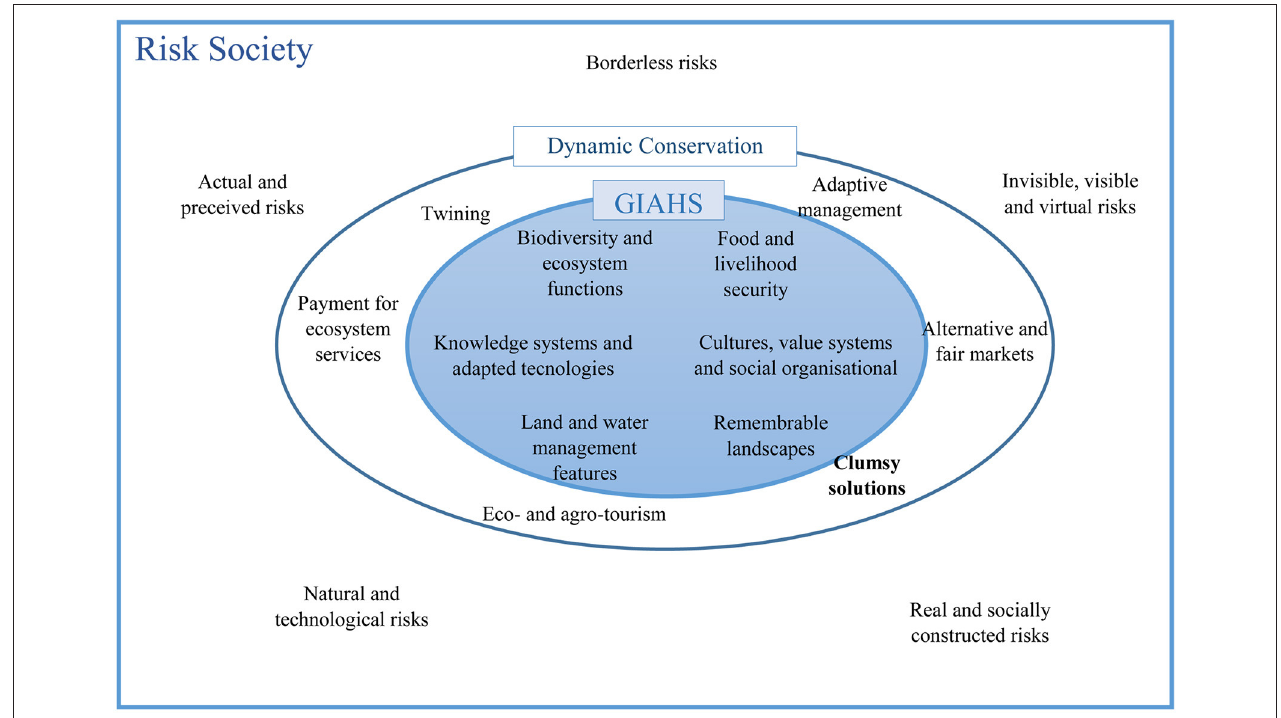
FIGURE 6 | Risk society, dynamic conservation, and agricultural